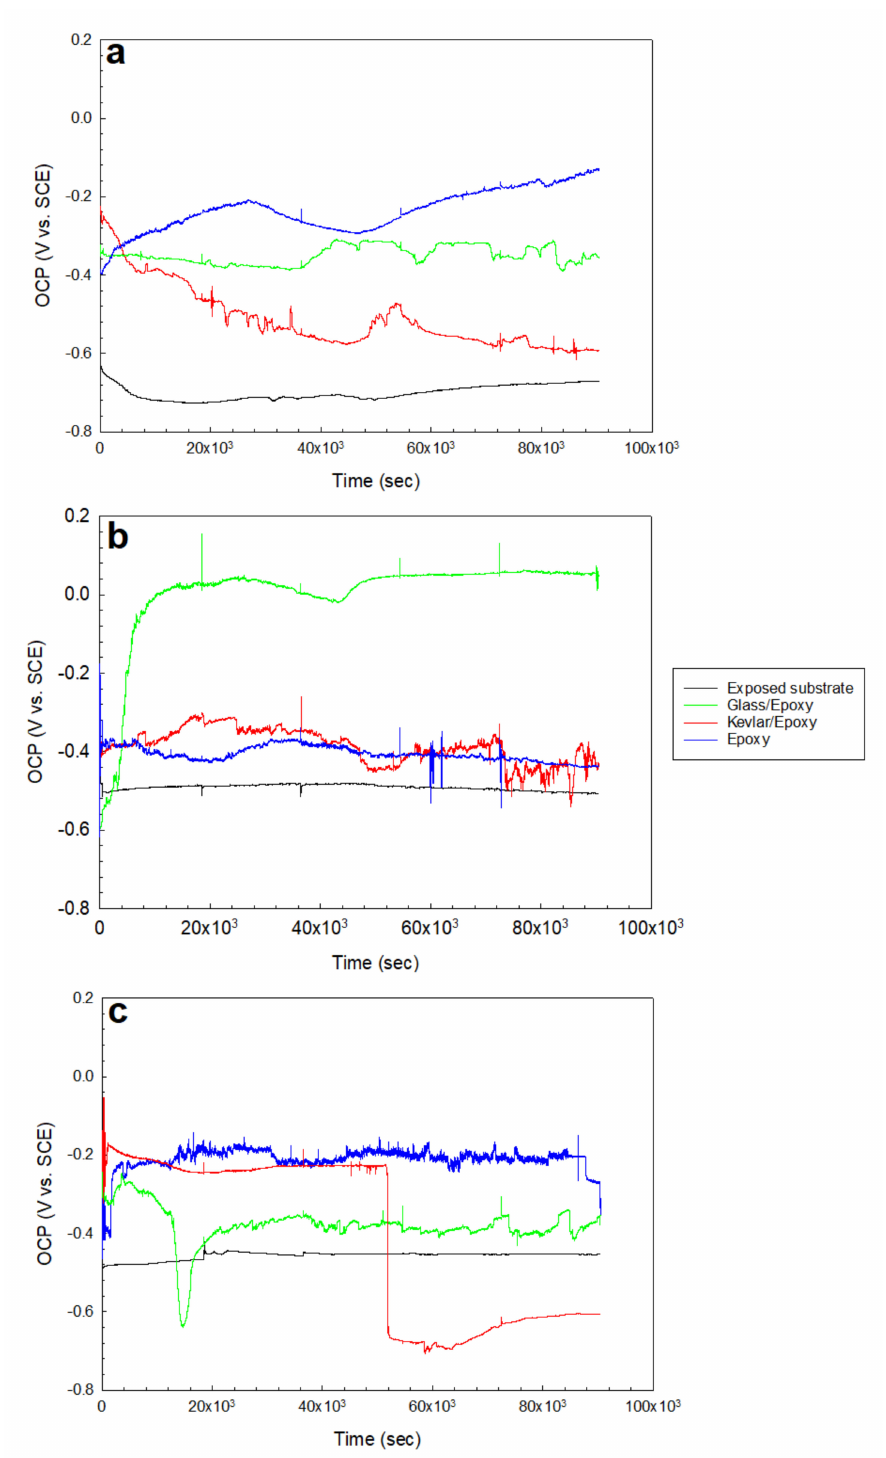
Figure 4. Open-circuit potentials in ( a ) 0.5 M NaCl, ( b ) 0.5 M HCl, and ( c ) 0.5 M H 2 SO 4 solutions for the exposed substrate and glass/epoxy, Kevlar/epoxy, and epoxy